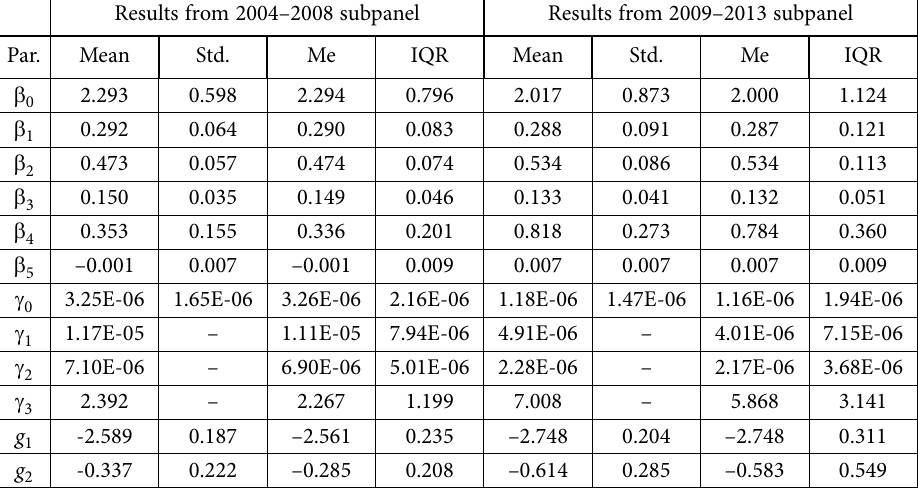
Table A3. Results from the two subpanels Results from 2004–2008 subpanel Results from 2009–2013